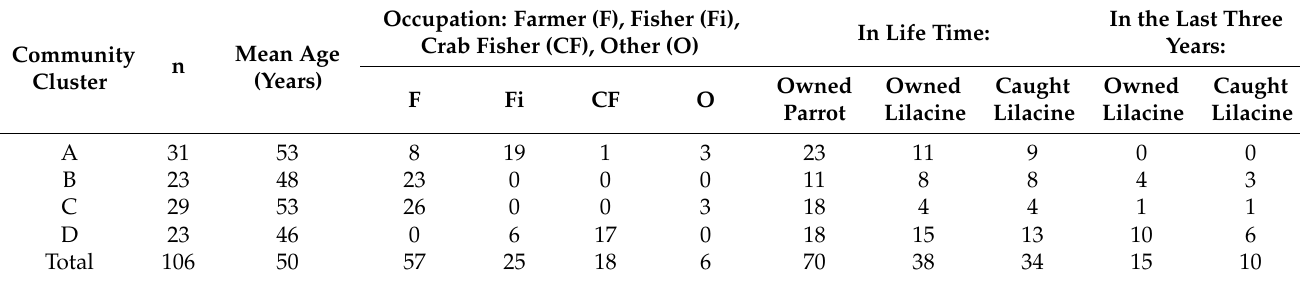
Table 4. The number, age and occupations of people interviewed from each community cluster and the number who reported owning parrots or catching parrots, either previously or in the last three years.